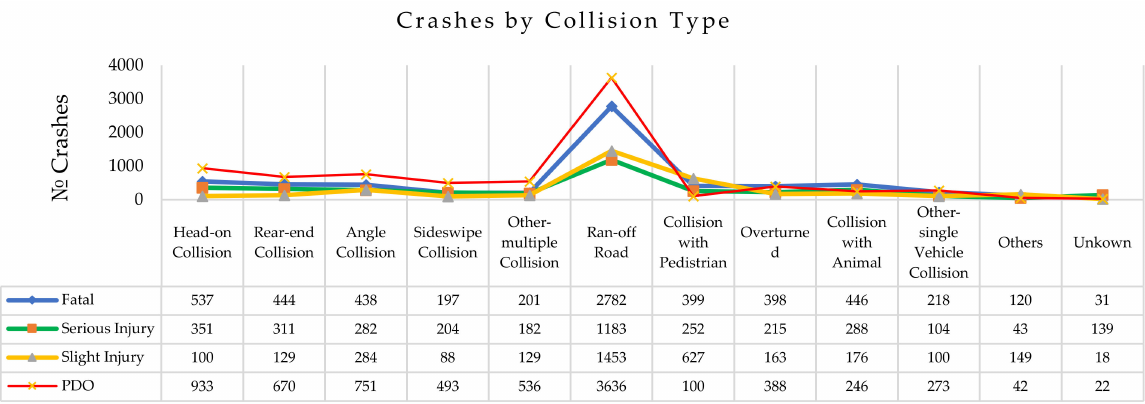
Figure 6. ( a ) Crashes occurred in a day of the week: from 2014–2017; ( b ) Crashes occurred in the time of the day: from 2014–2017.